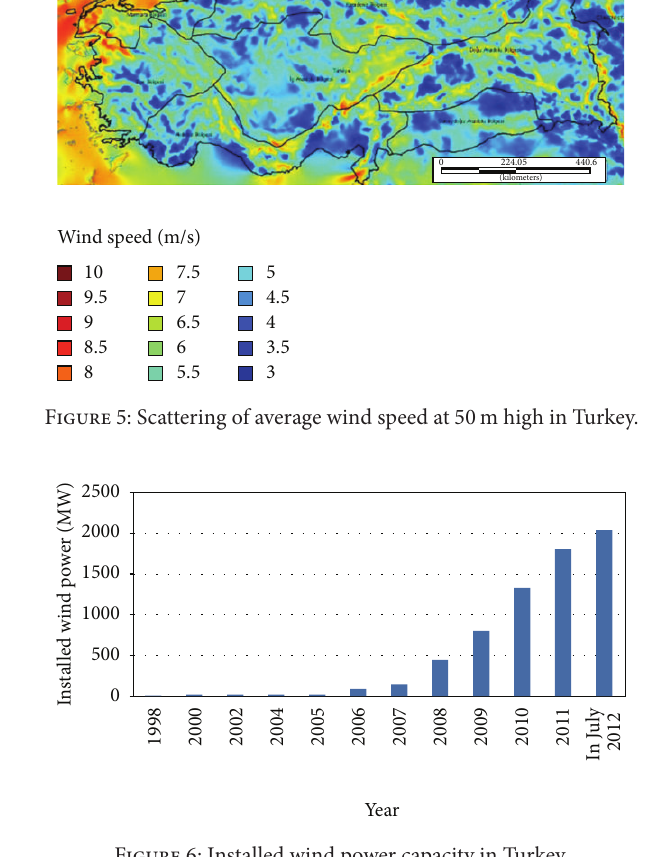
Figure 6: Installed wind power capacity in